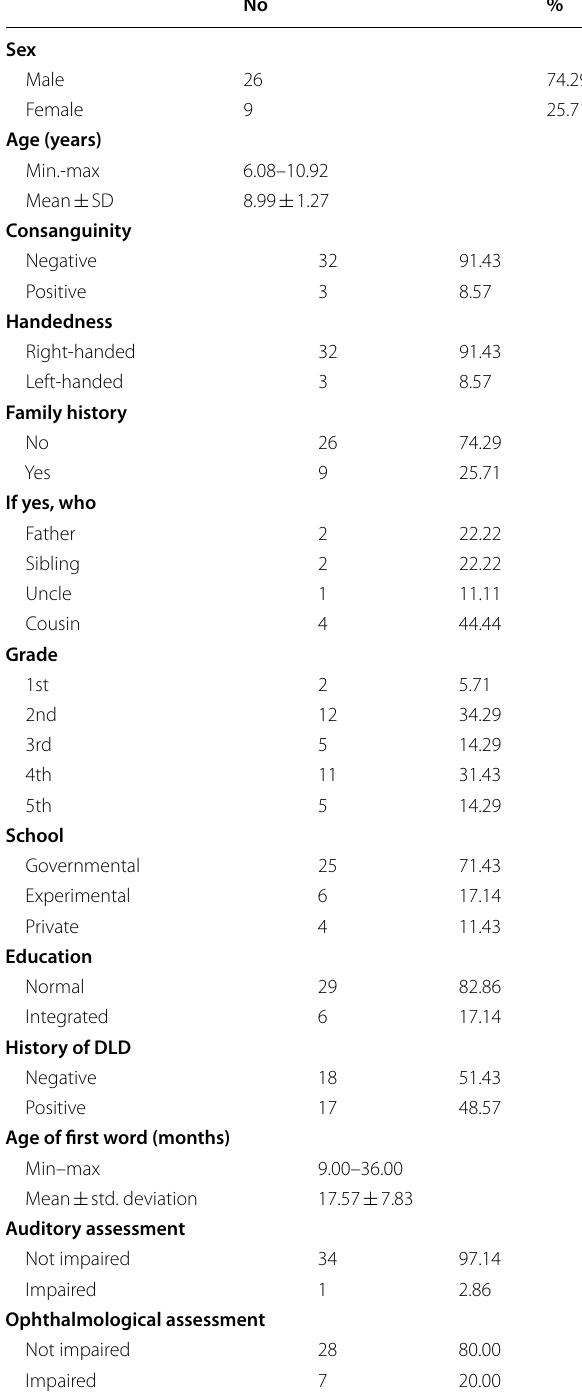
Table 1 Distribution of the studied cases according to demographic data and